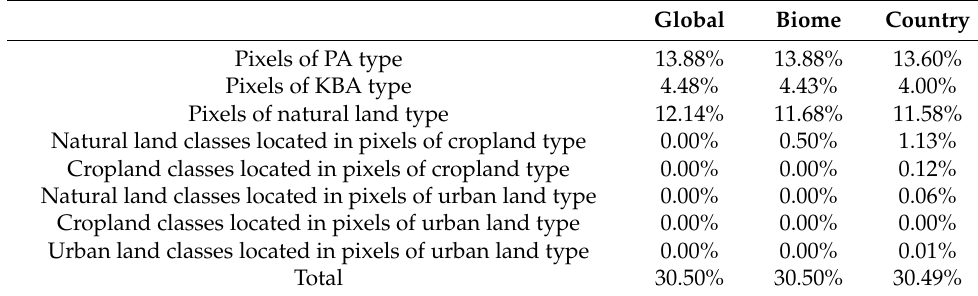
Table 2. 2030 shared: percentage of conserved area to global terrestrial area.